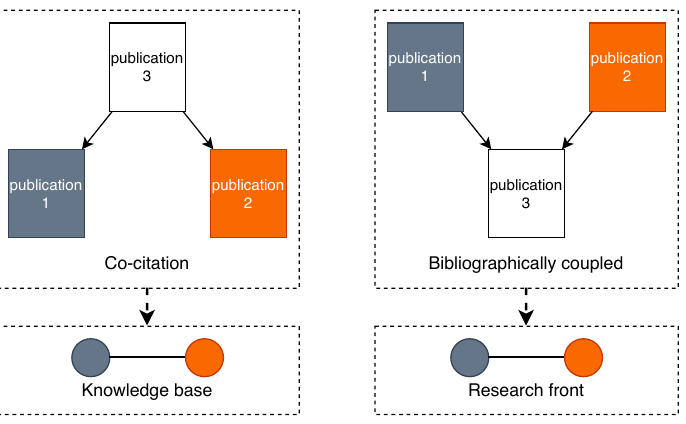
Figure 3. Co-citation and bibliographic coupling